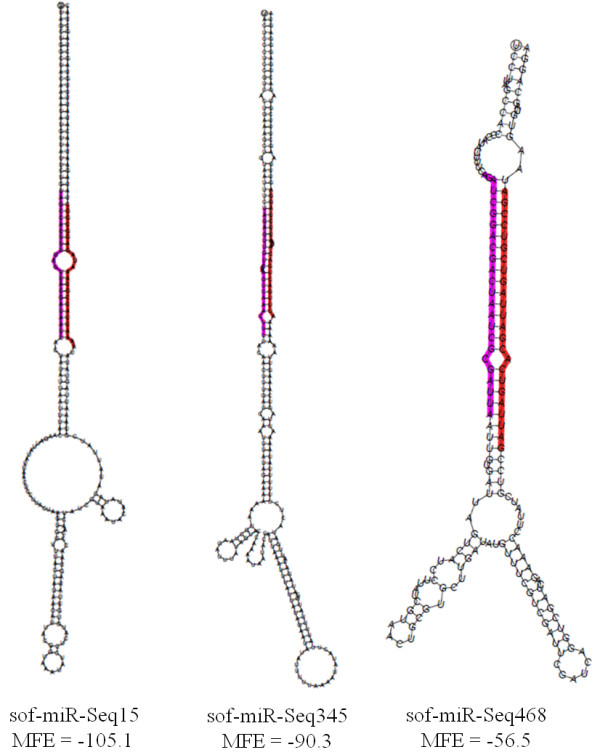
Example of secondary structure of selected novel MIR genes, consideredbona fideprecursors. The sugarcane mature miRNA (red), miRNA* (pink) were illustrated and MFE value of stem-loop structure were also shown.